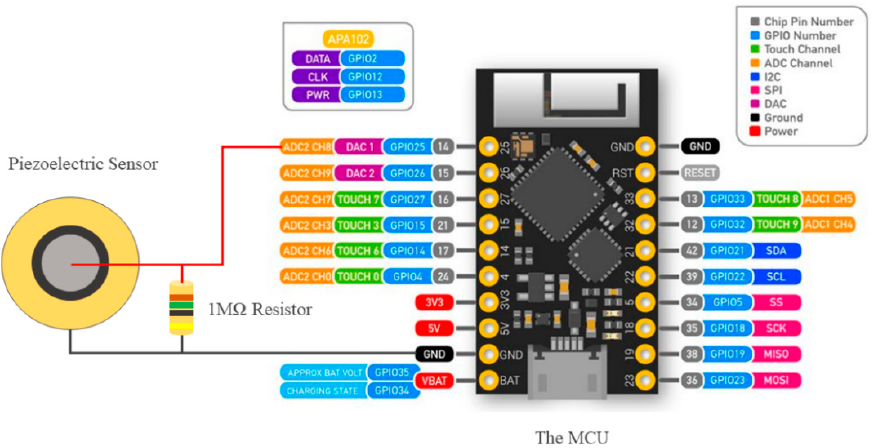
Figure 5. Characterization setup of the Piezoelectric Sensor.